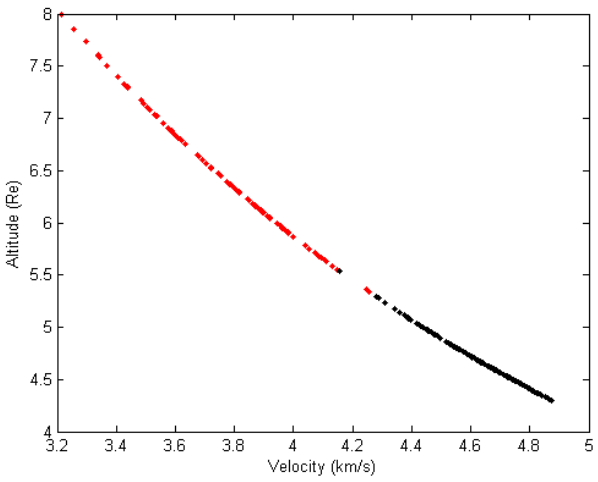
Fig. 4. Altitude and velocity of the satellites when they encounter the cusp in the Northern (black) and Southern (red)